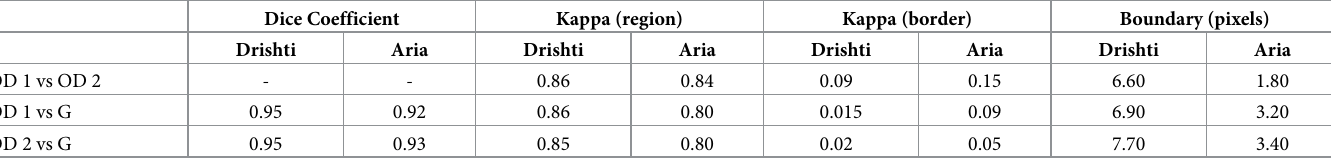
Table 1. The values for DC, kappa, and boundary when comparing OD1 with OD2, OD1 with ground truth (G), and OD2 with ground truth (G) before applying ellipse fitting. Dice Coefficient